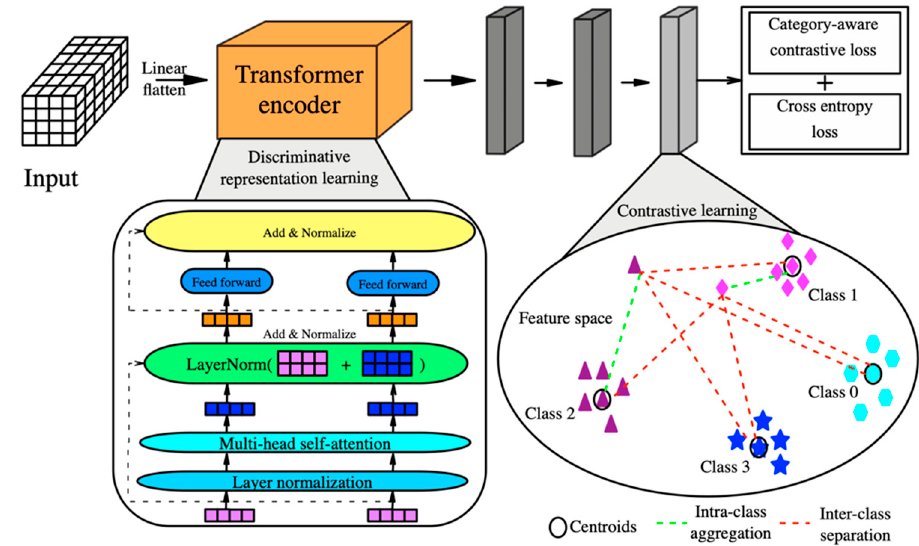
Figure 3. A pipeline showing the developed rock and mineral classification